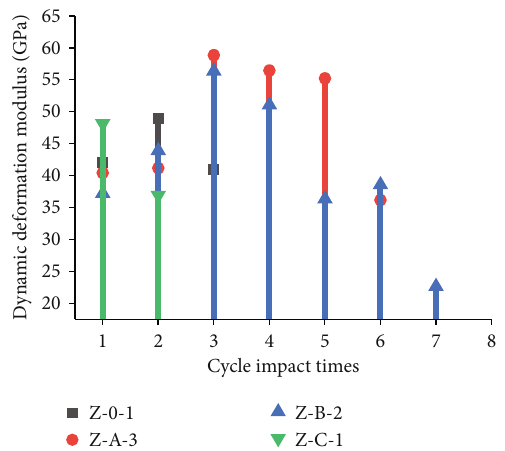
Figure 10: Relationship between the dynamic deformation modulus and the number of